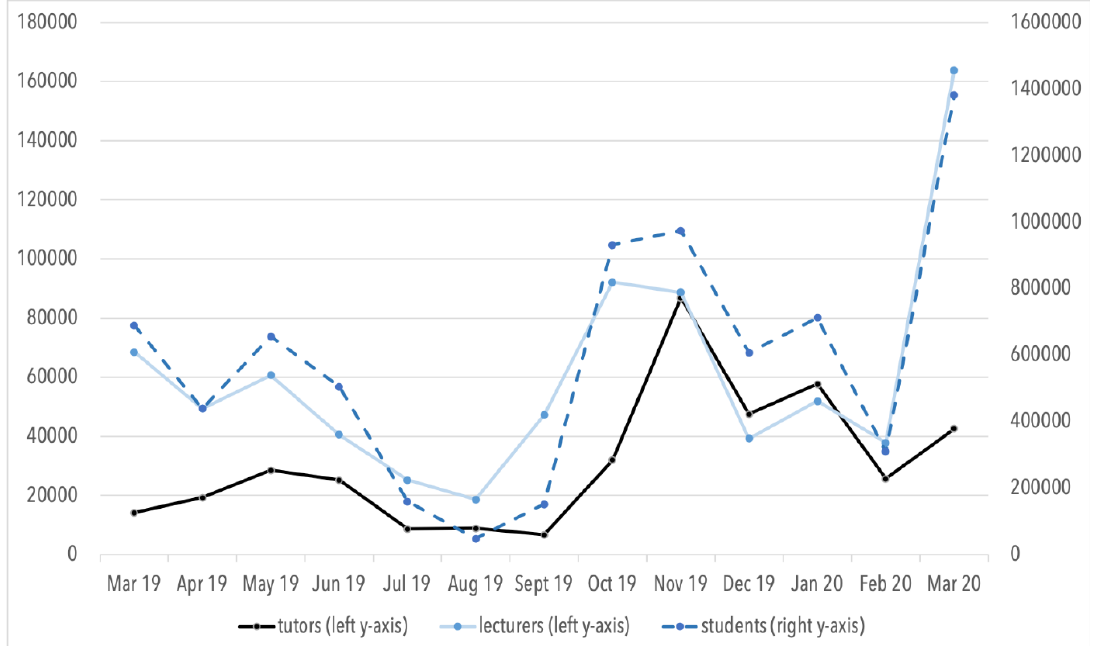
ff erent user groups per month from March